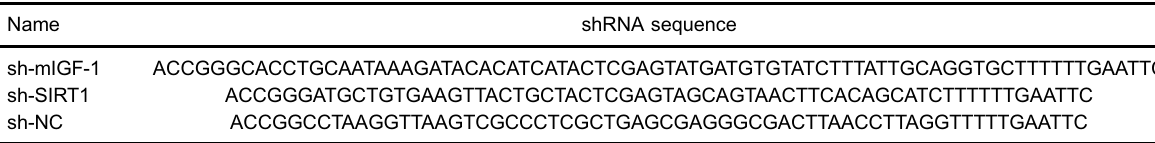
Table 2. Sequence of sh-mIGF-1, sh-SIRT1, and sh-NC